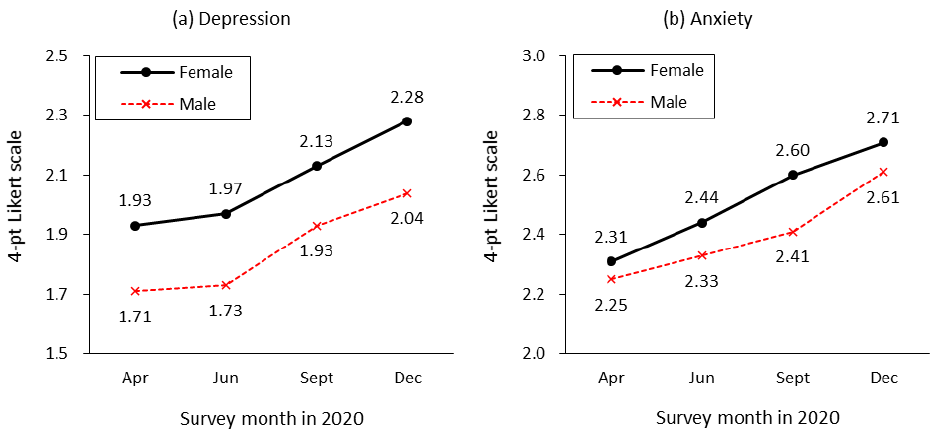
Figure 2. Mental health by gender during the first year of the COVID-19 pandemic. Notes: Depression and anxiety were measured using a 4-point Likert scale ranging from 1 (not at all) to 4 (very severe).